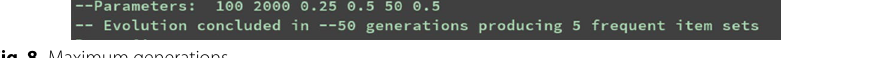
Fig. 8 Maximum generations